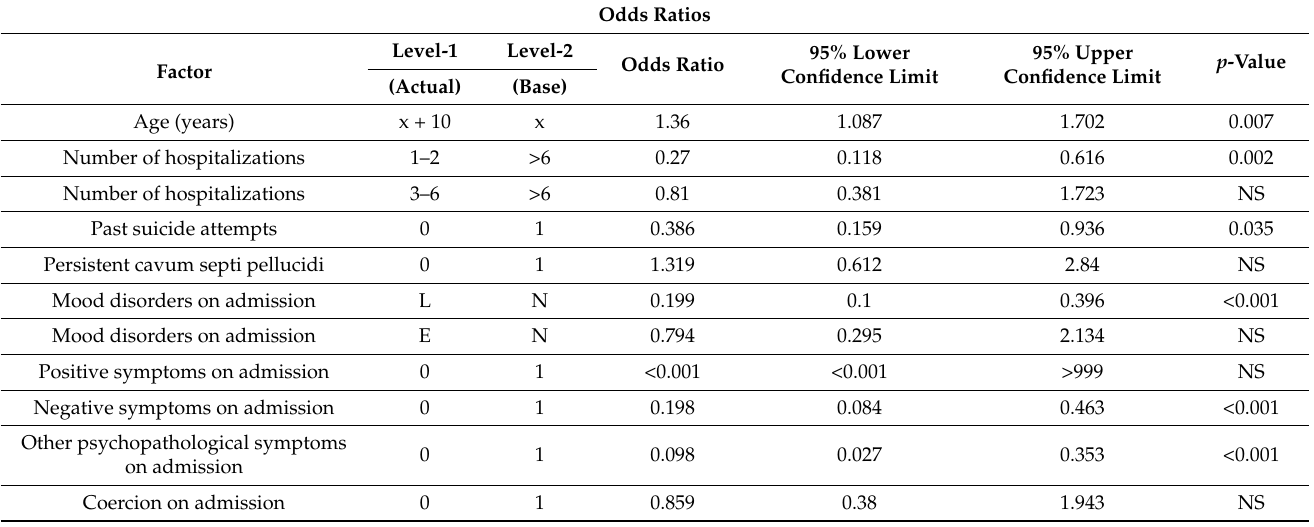
Table 2. Multivariate model—odds ratio values for the parameters affecting the presence of positive symptoms at hospital